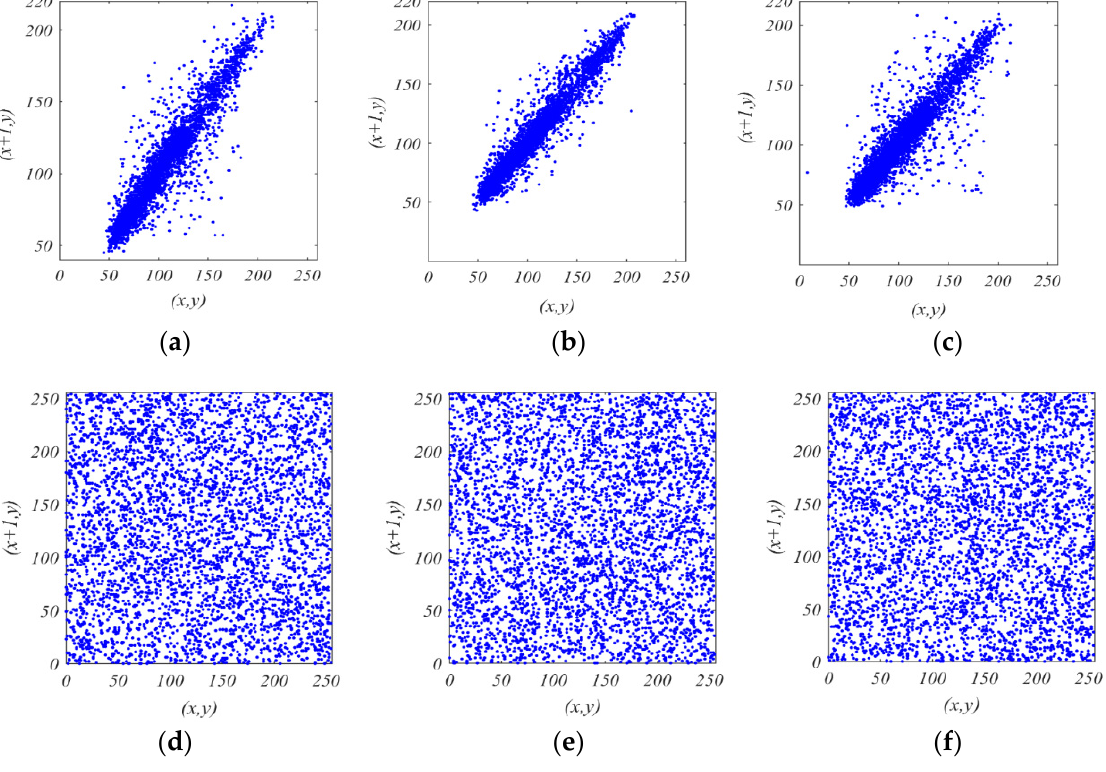
Figure 21. Correlation analysis of the B band of a plain Lena image and its consistent encrypted image: ( a , d ) horizontal c arrangement, ( b , e ) vertical arrangement, ( c , f ) diagonal arrangement.